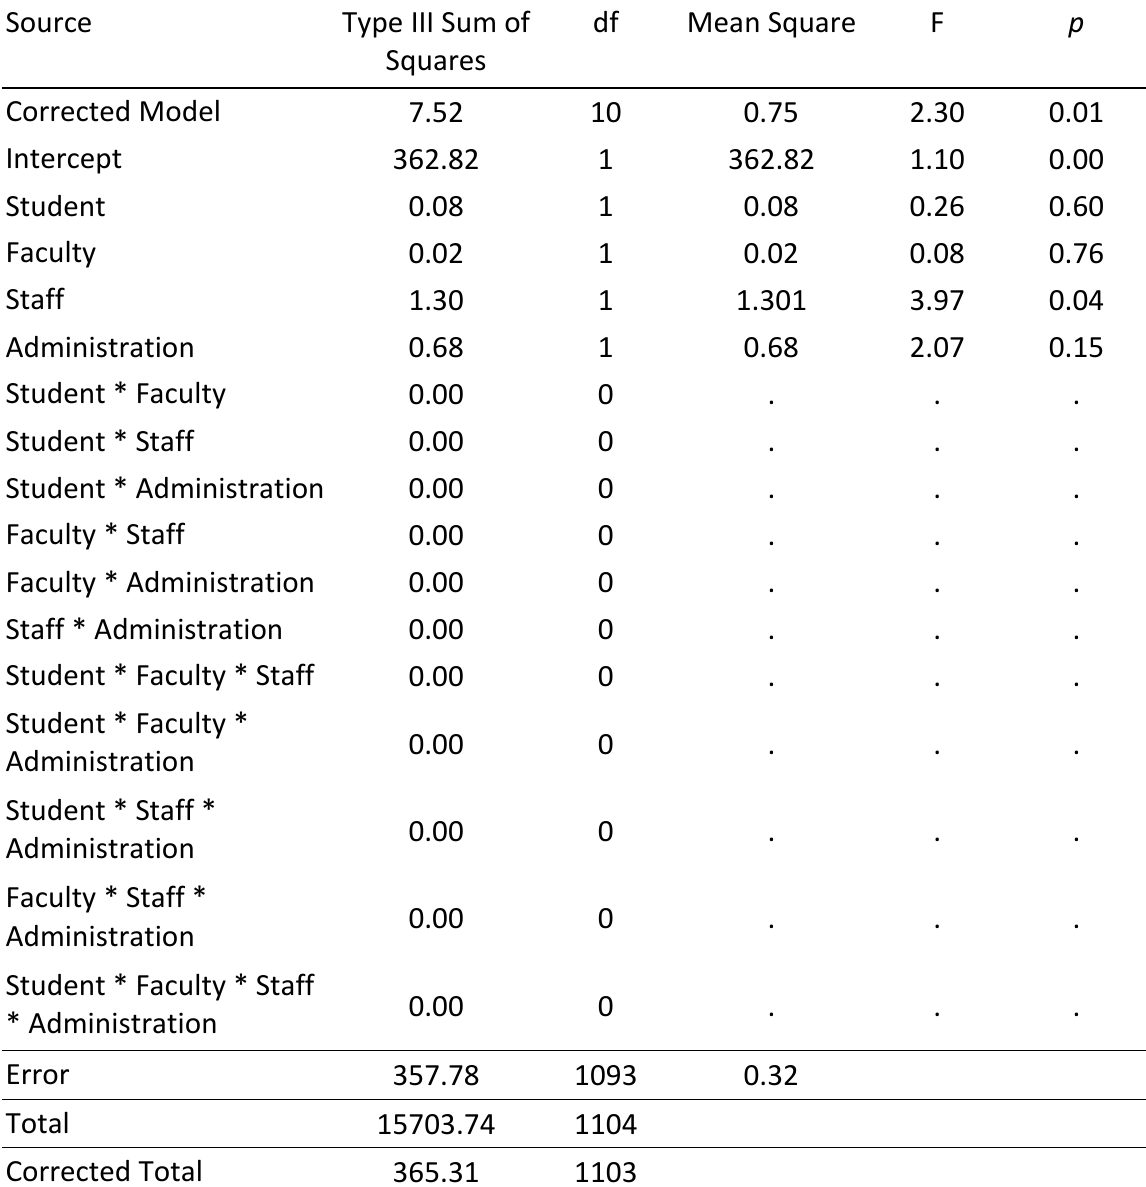
Table 5 Tests of Between-Subjects Effects Source Type III Sum